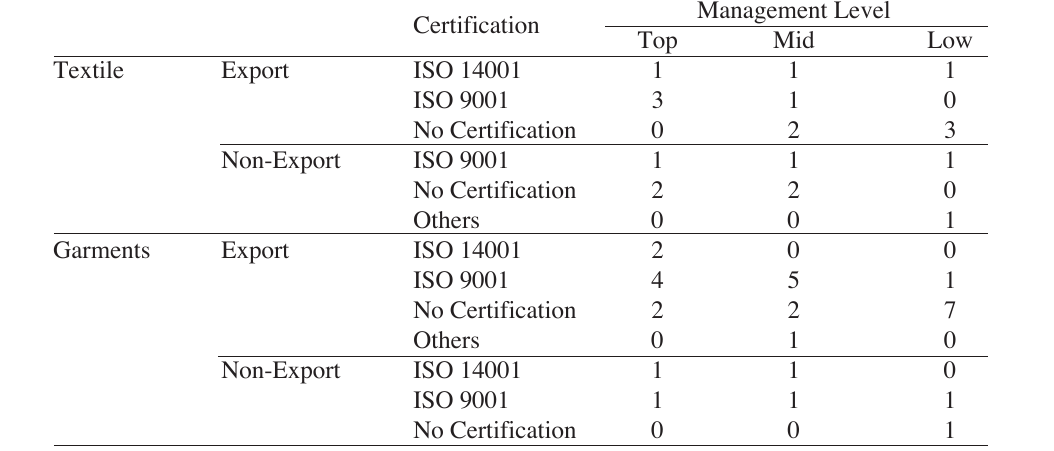
Cross-tabulation between Management Position and HSE